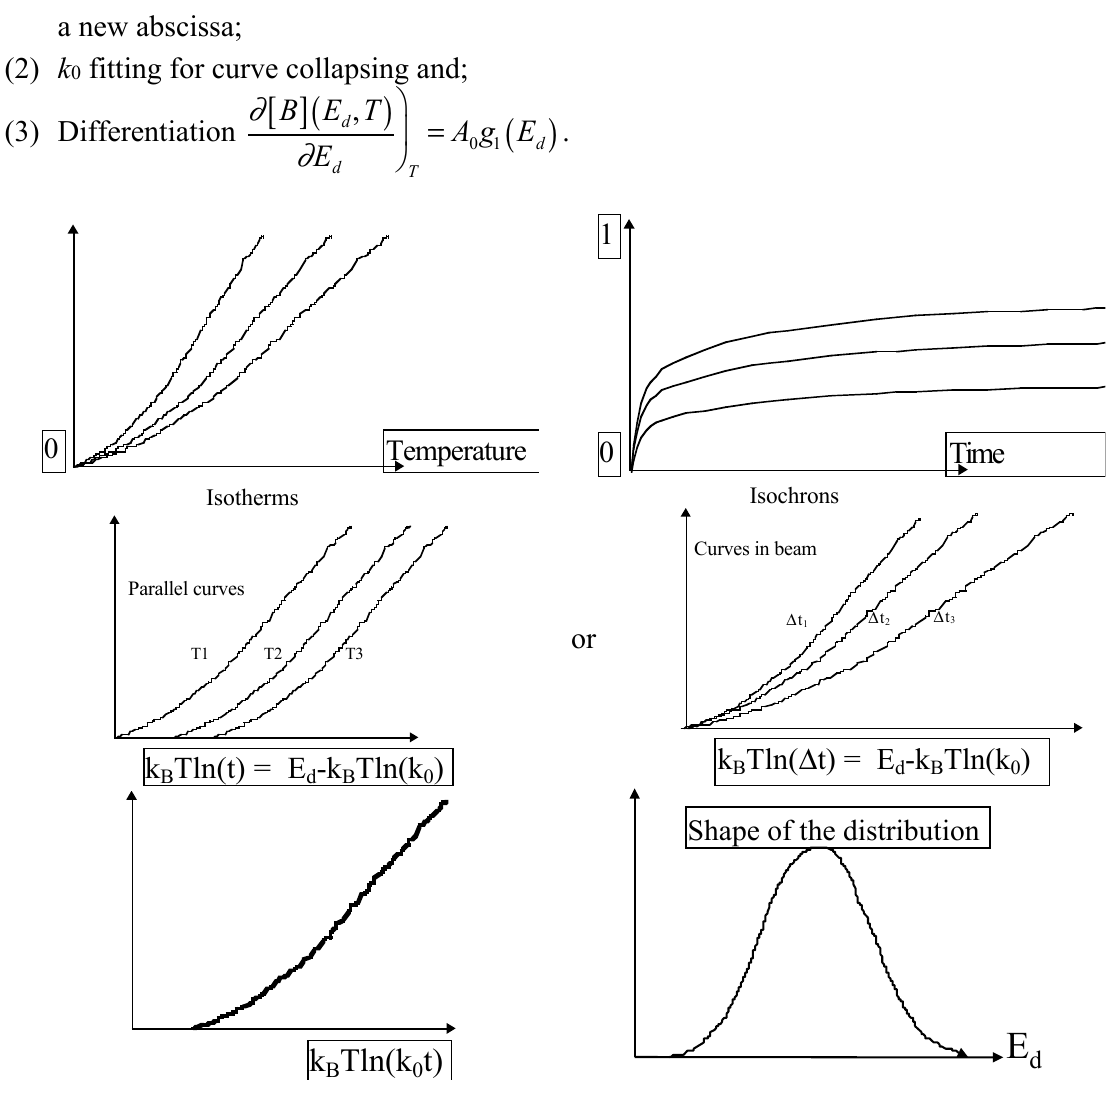
Figure 23. Procedure to obtain k 0 and g ( E